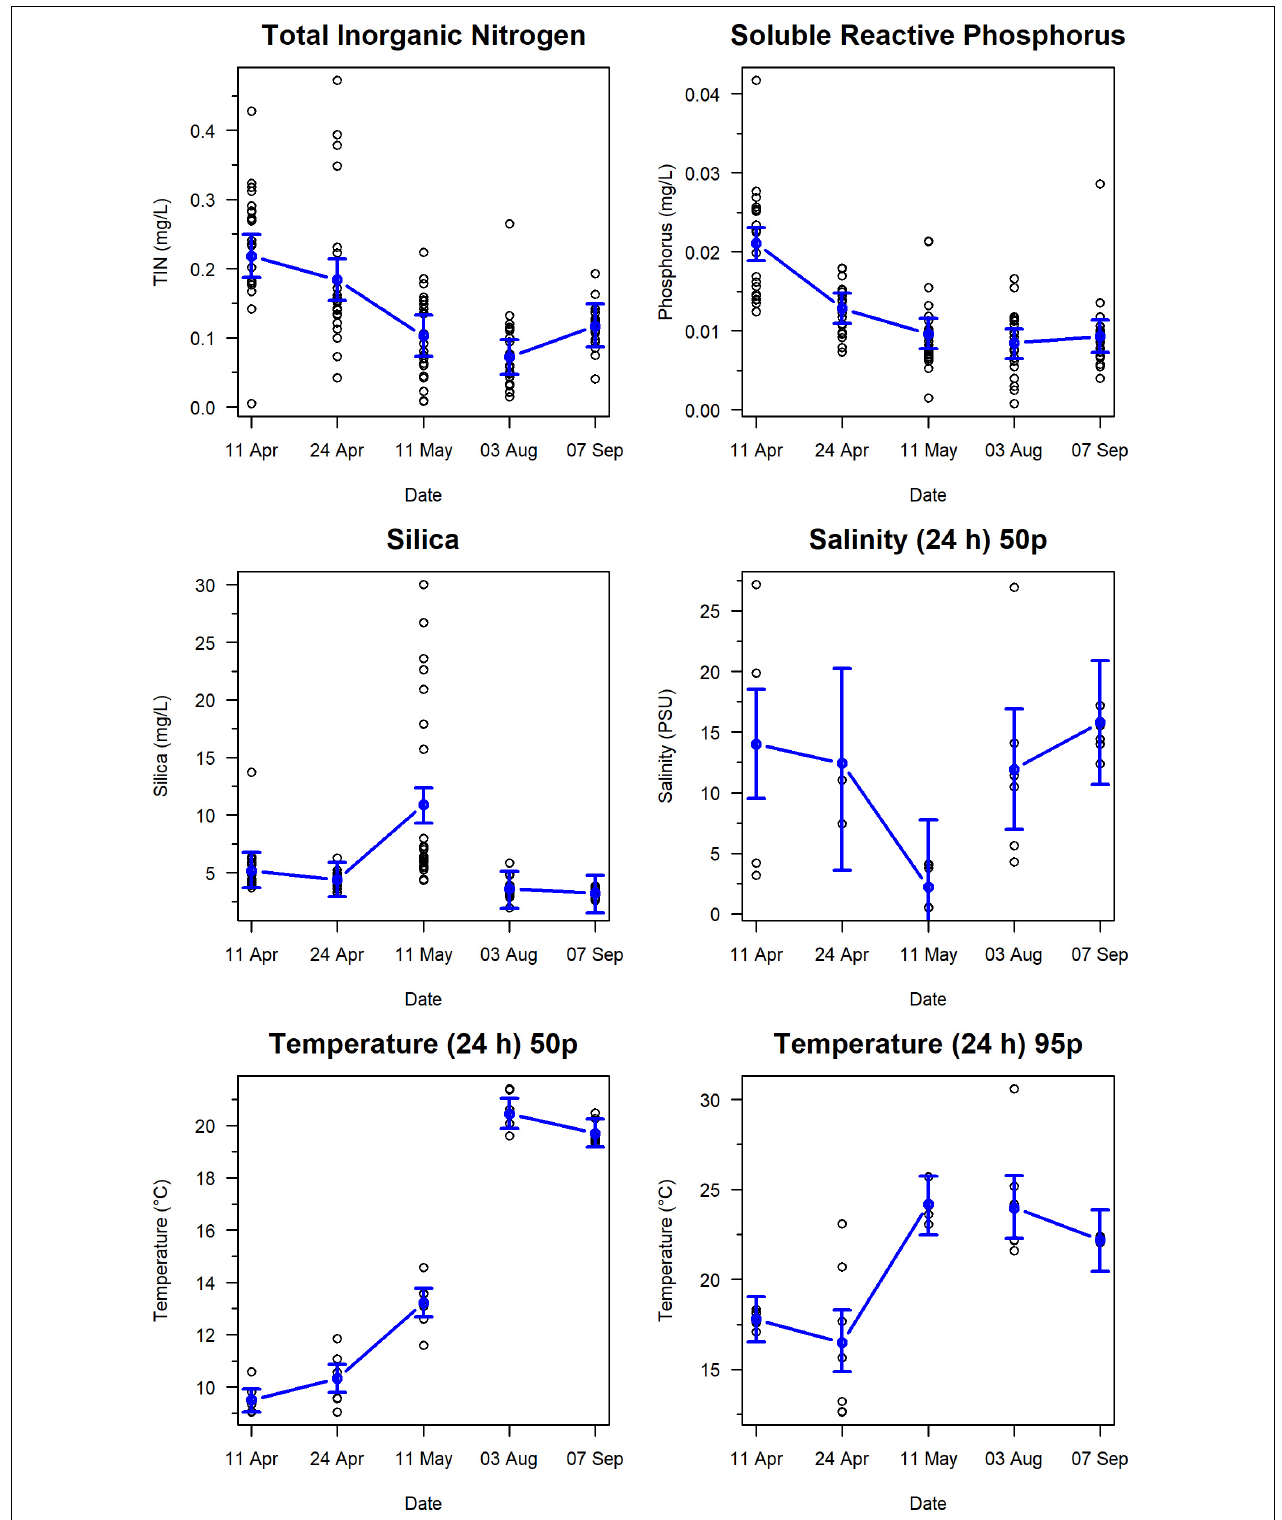
FIGURE 4 | Temporal changes in nutrients and water conditions on Roberts Bank, Fraser River Delta, British Columbia, 2017. Blue circles indicate predicted means, and bounds are 95% prediction intervals from linear mixed effects models. Variables plotted are Total Inorganic Nitrogen, Soluble Reactive Phosphorus, Silica, Salinity (24 h) 50 percentile, Temperature (24 h) 50th percentile, and Temperature (24 h) 95th percentile.